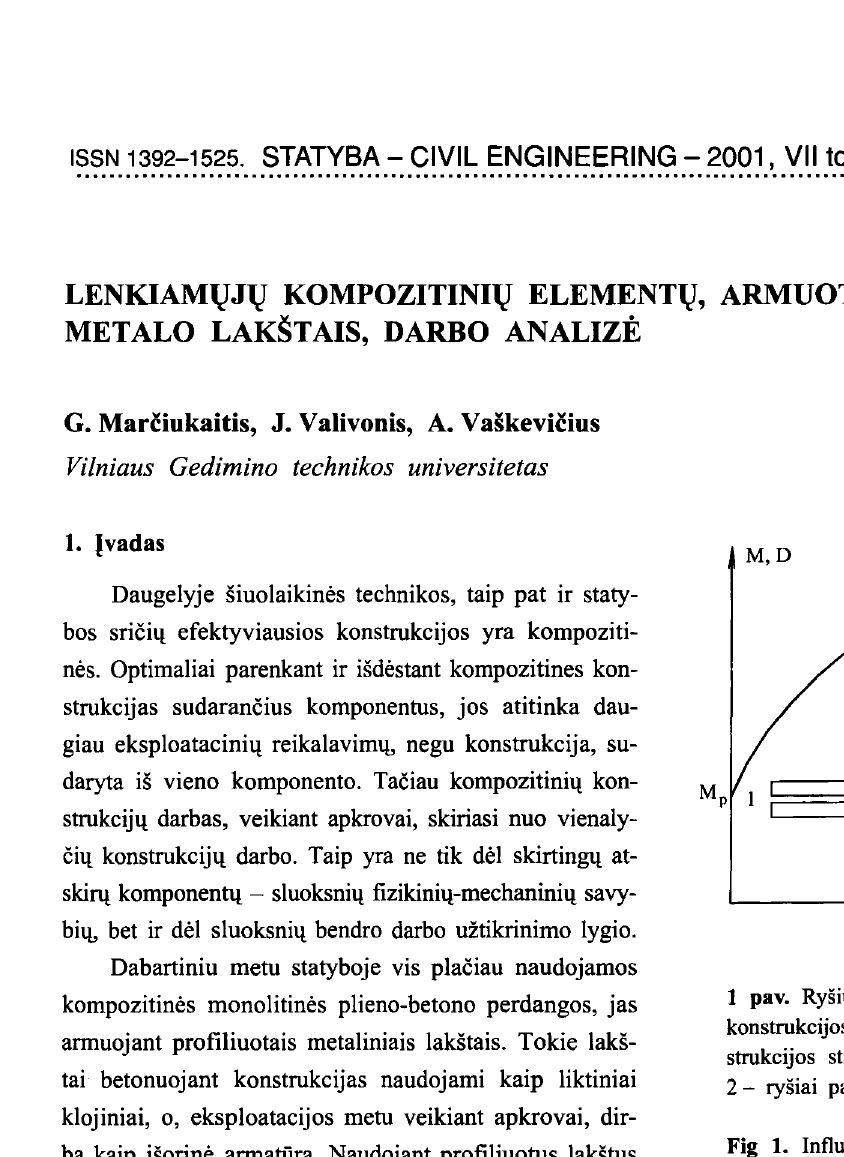
1 pav. Rysiq tarp sluoksniq stiprumo (standumo) itaka konstrukcijos darbui veikiant apkrovai: M, D - kon strukcijos stiprumas ir standumas; I - kai rysiq nera; 2 - rysiai pasiduodantys; 3 - rysiai standiis ir stipriis Fig 1. Influence of strength (stiffness) of connections between the layers on structure behaviour under the lo ad: M, D - strength and stiffness of the structure; I - without connections; 2 - yielding connections; 3 - stiff and strong connections kas). Didinant rysio standuml! bendras konstrukcijos stiprumas ir standumas taip pat dideja (1 pav. 2 krei ve). 2 kreives ruoze (tarp 1 ir 3 tasktt) konstrukcija suirs del slyties itempimtt sluoksniq kontakto plokstu moje. Kai rysiai yra pakankamai standiis ir stipriis (3 taskas ir toliau), konstrukcija suirs istrizame arba stat mename pjiivyje. Vadinasi, sluoksniuotosios konstruk cijos nuo vienasluoksnitt skiriasi ir tuo, kad projektuo jant pirml!sias reikia apskaiciuoti ne dviejl.L o trijtt pjii viq: istrizojo, vertikaliojo ir horizontaliojo (sluoksniq kontakto plokstumoje)